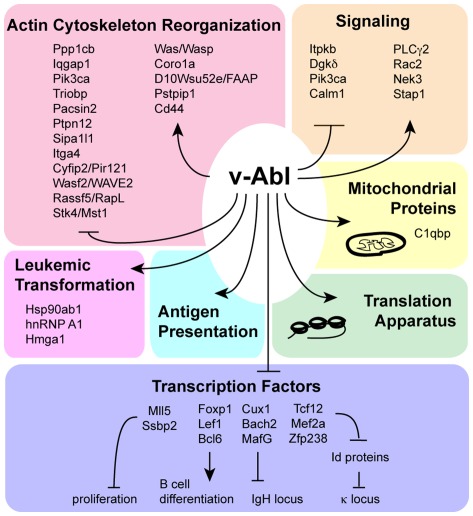
A summary of the contribution of v-Abl translational re-programming to differentiation arrest and leukemogensis.